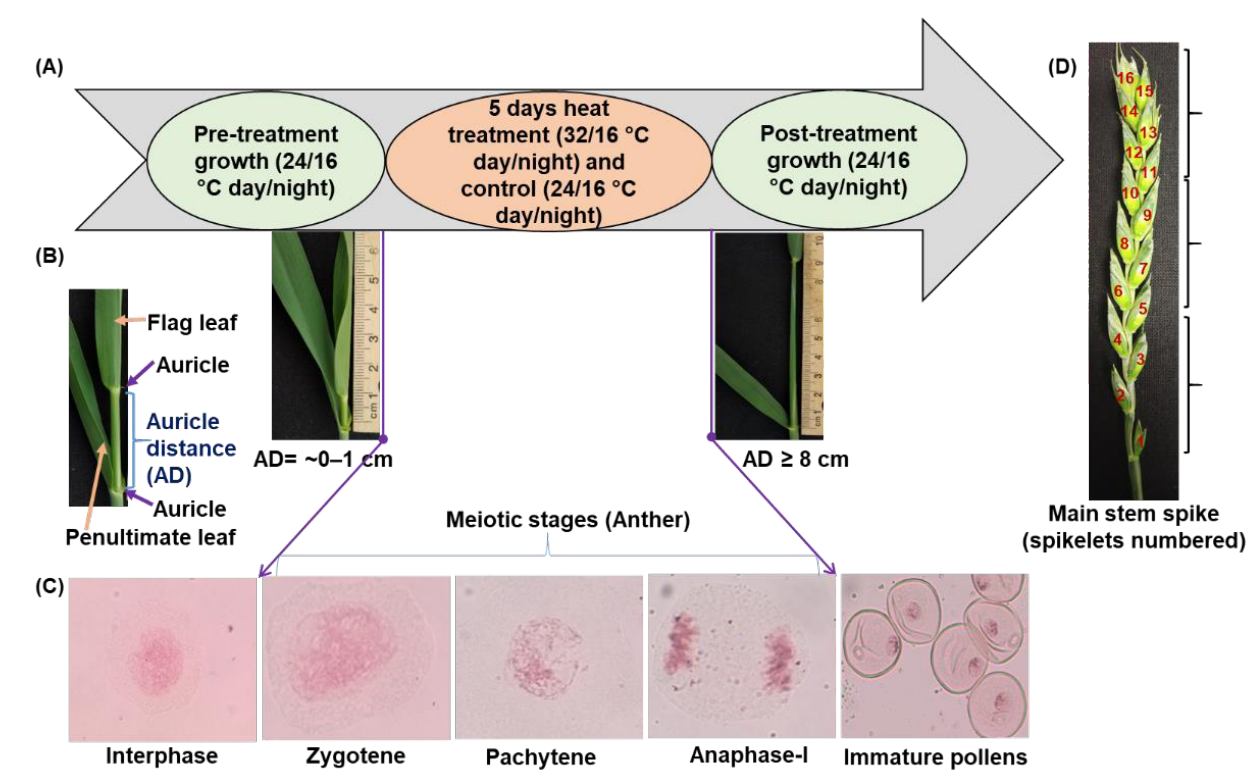
Figure 1. Overview of ( A ) timing of heat stress in relation to ( B ) auricle distance (AD, cm) and ( C ) stages of meiosis in wheat. Meiosis (in anthers) starts when AD reaches 1 cm in most cultivars and ends at AD 8 cm under heat stress. Immature pollen grains (microspores) are formed in anthers after AD ≥ 8 cm. ( D ) The heat treatment effect on grain number and grain weight in the main stem spike is measured on spikelets from the base upwards.